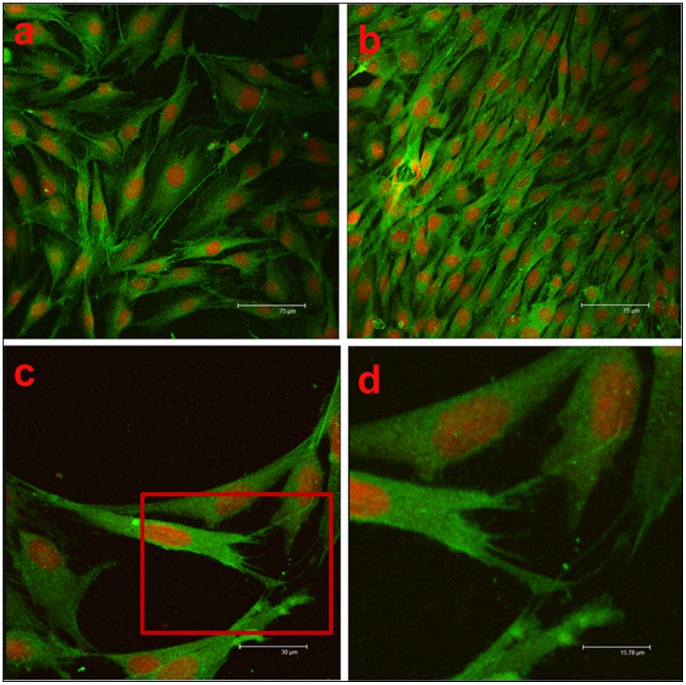
The morphology and distribution of cells cultured for 4 days on each scaffold.(a) PA66 scaffold (×200) (b) n-HA/PA66/GF scaffold (×200) (c) n-HA/PA66/GF scaffolds (×500) (d) higher magnification of cells corresponding to the rectangle region in (c). (×1000).